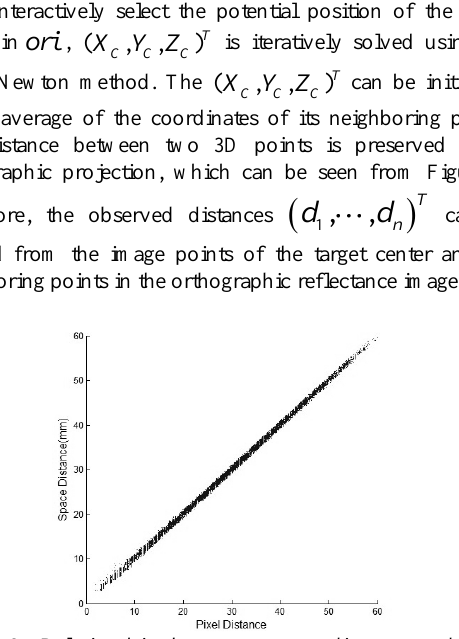
Figure 3. Relationship between space distance and pixel